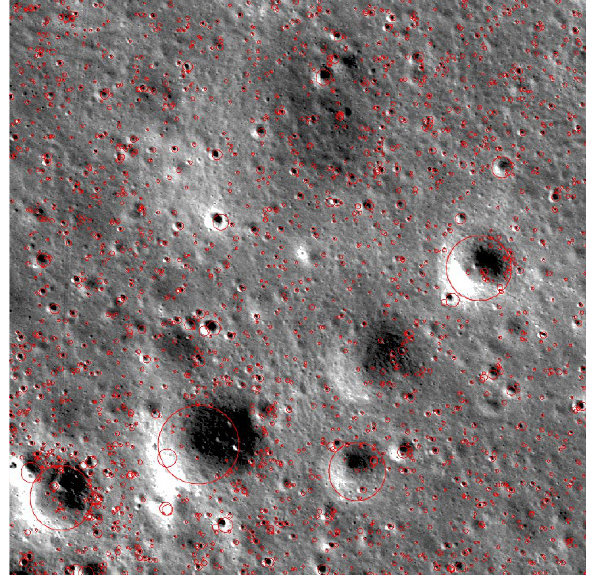
Figure 1. The detection result of craters in the LROC image From above detected result, it can be seen that our proposed method can detect different scales craters, especially these small- scale craters. At the same time, it can be seen that our proposed method is not affected by light direction and nonuniformity of light. The incorrectly detected craters are always those next to